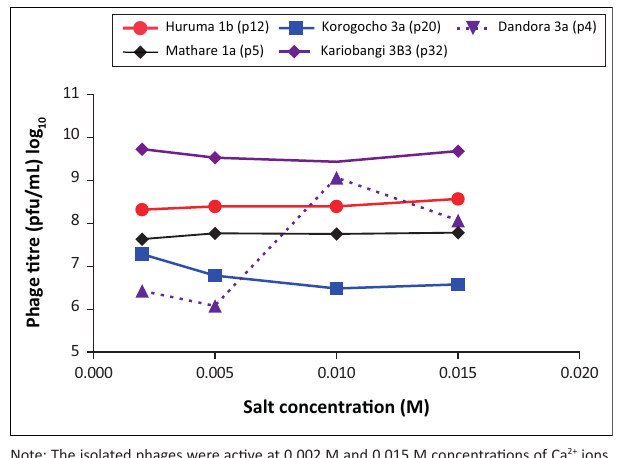
FIGURE 3: Effect of salt on phages isolated in Nairobi County, Kenya, July 2019 to December 2020. Phages were named based on source and phage strain number, for example Huruma 1b (p12) means Huruma 1b source; phage strain number